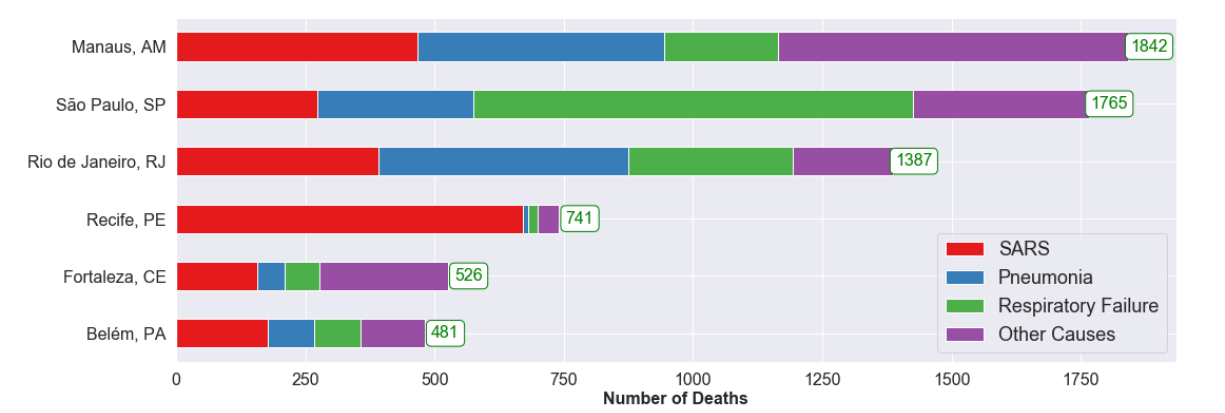
Figure 4. Estimated number of deaths wrongfully attributed to respiratory system diseases for the considered periods. SARS: severe acute respiratory